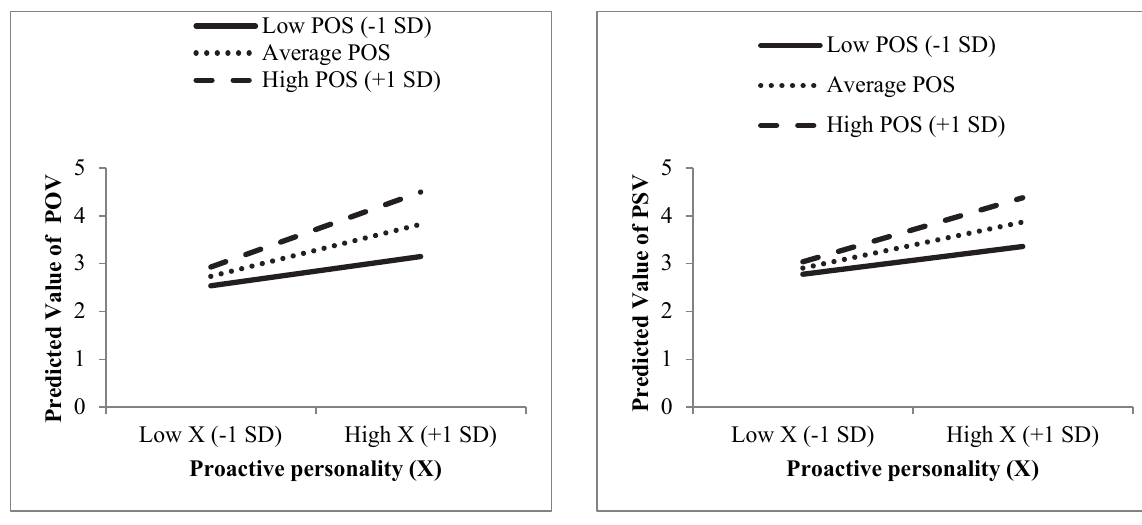
Fig. 2. POS as a moderator in the relationship between PP and POV